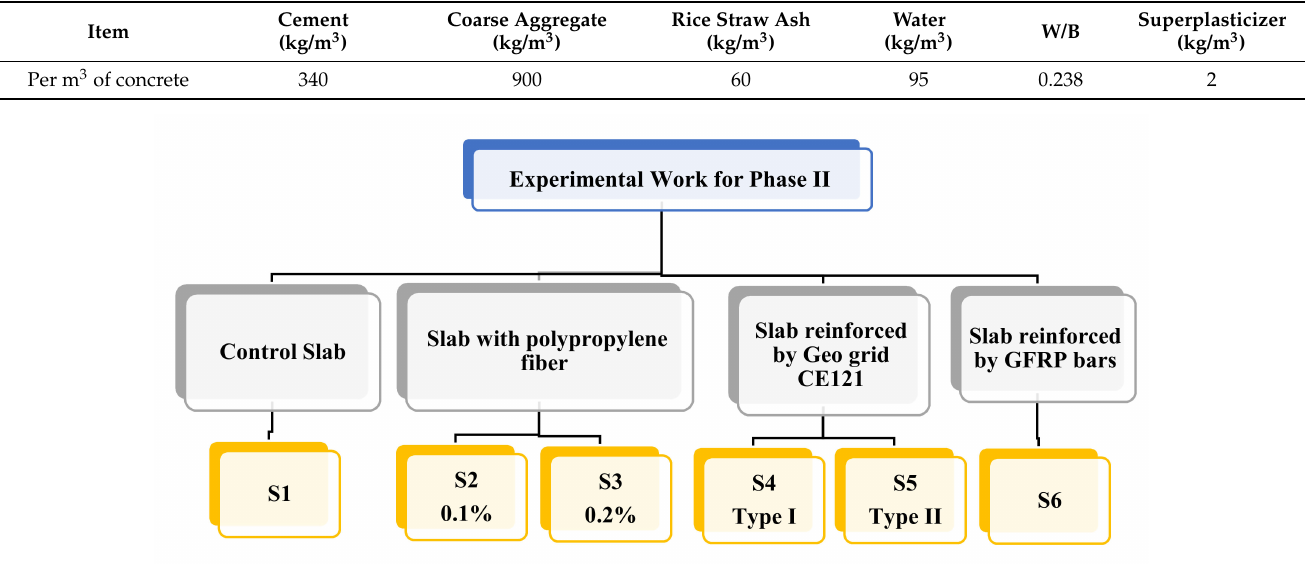
Figure 4. Experimental program for Phase